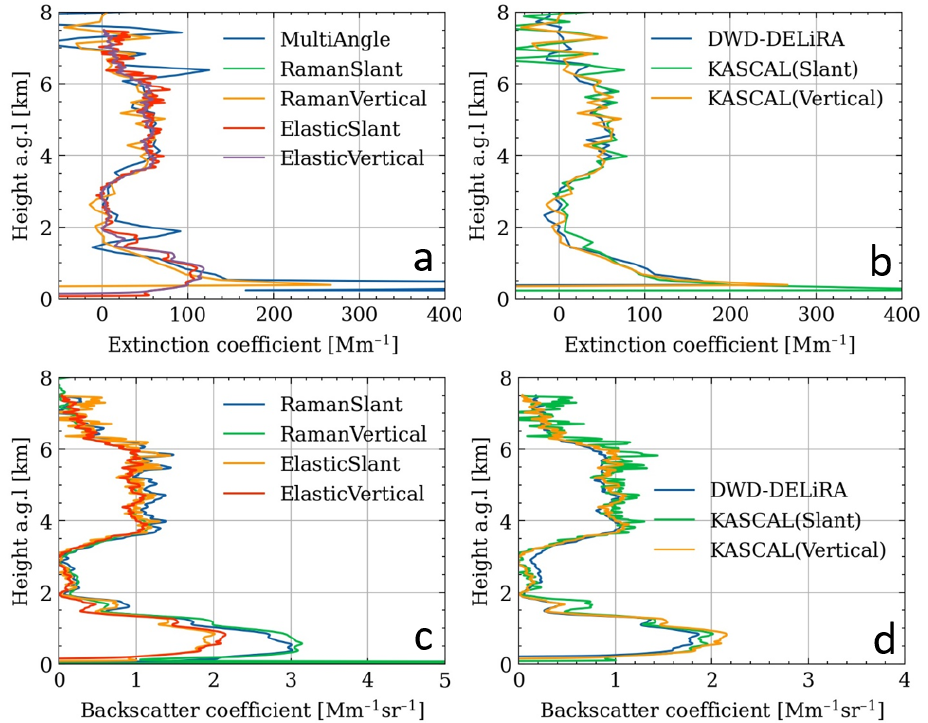
Figure 6. Extinction coefficients ( a ) and backscatter coefficients ( c ) from the elastic and Raman retrieval methods are shown on the left (KASCAL). On the right, the Raman extinction coefficients ( b ) and elastic backscatter coefficients ( d ) are given for different optical paths for measurements in the time from 19:21 to 22:54 (UTC) on 8 April 2018. Two vertical paths are from DWD-DELiRA and KASCAL, and one slant path is from